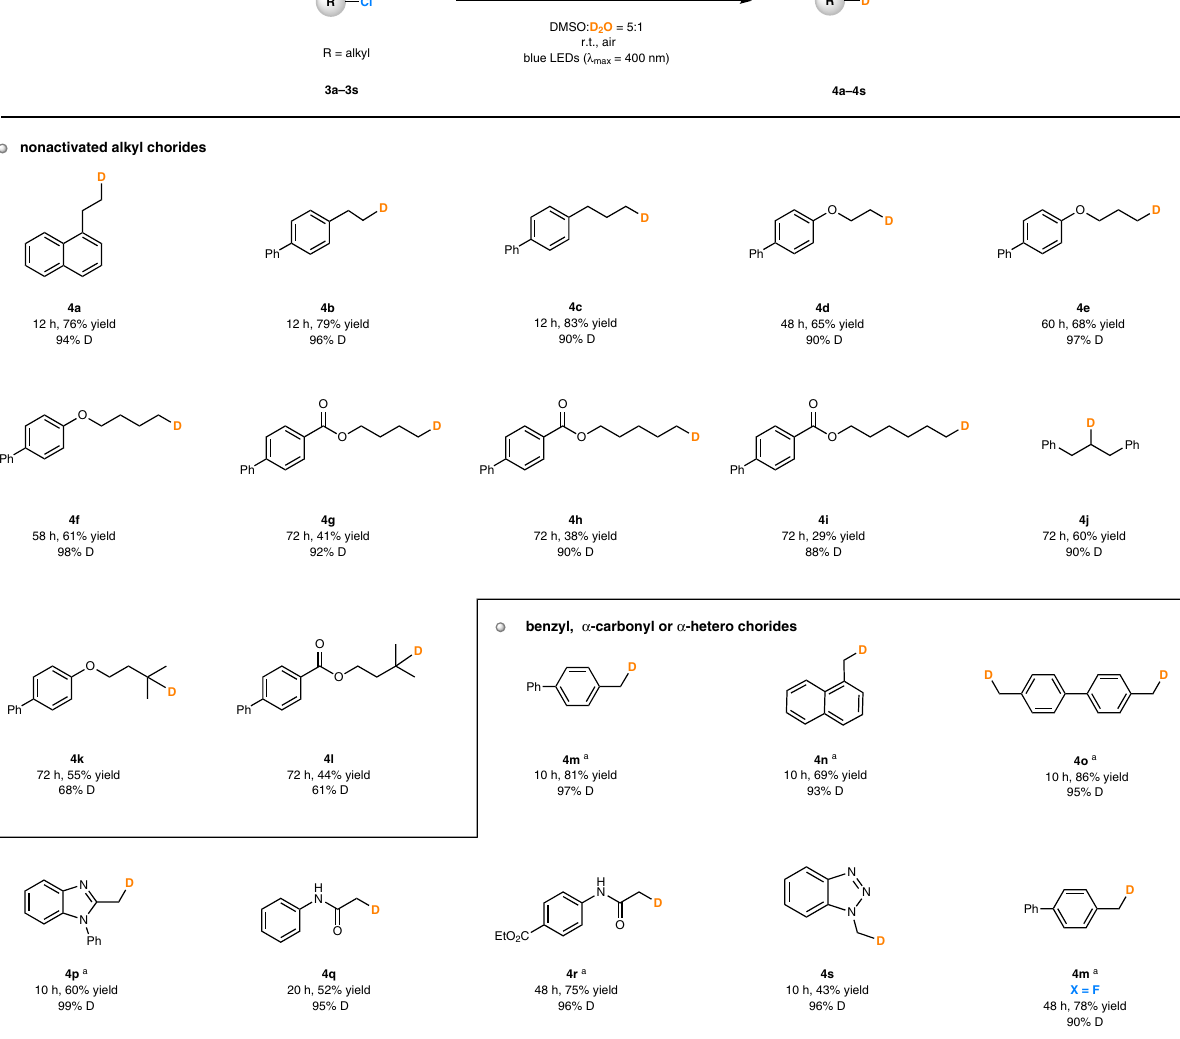
Fig. 5 Scope of photocatalytic deuterodehalogenation of alkyl chlorides. a PC4 (10 mol%). PC, photocatalyst; r.t., room temperature; eq, equivalent; DMSO, dimethyl